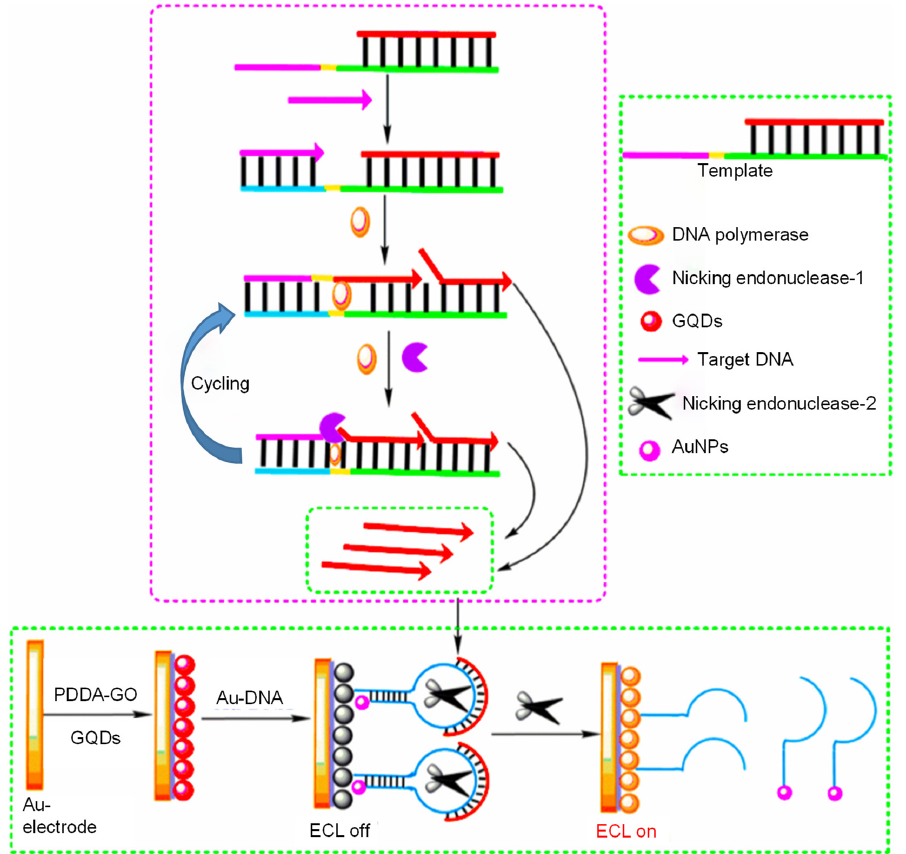
Figure 12. The mechanism involved in detecting DNA by GQD electrochemiluminescence (ECL) assembled with the multiple cycling amplification method [212].